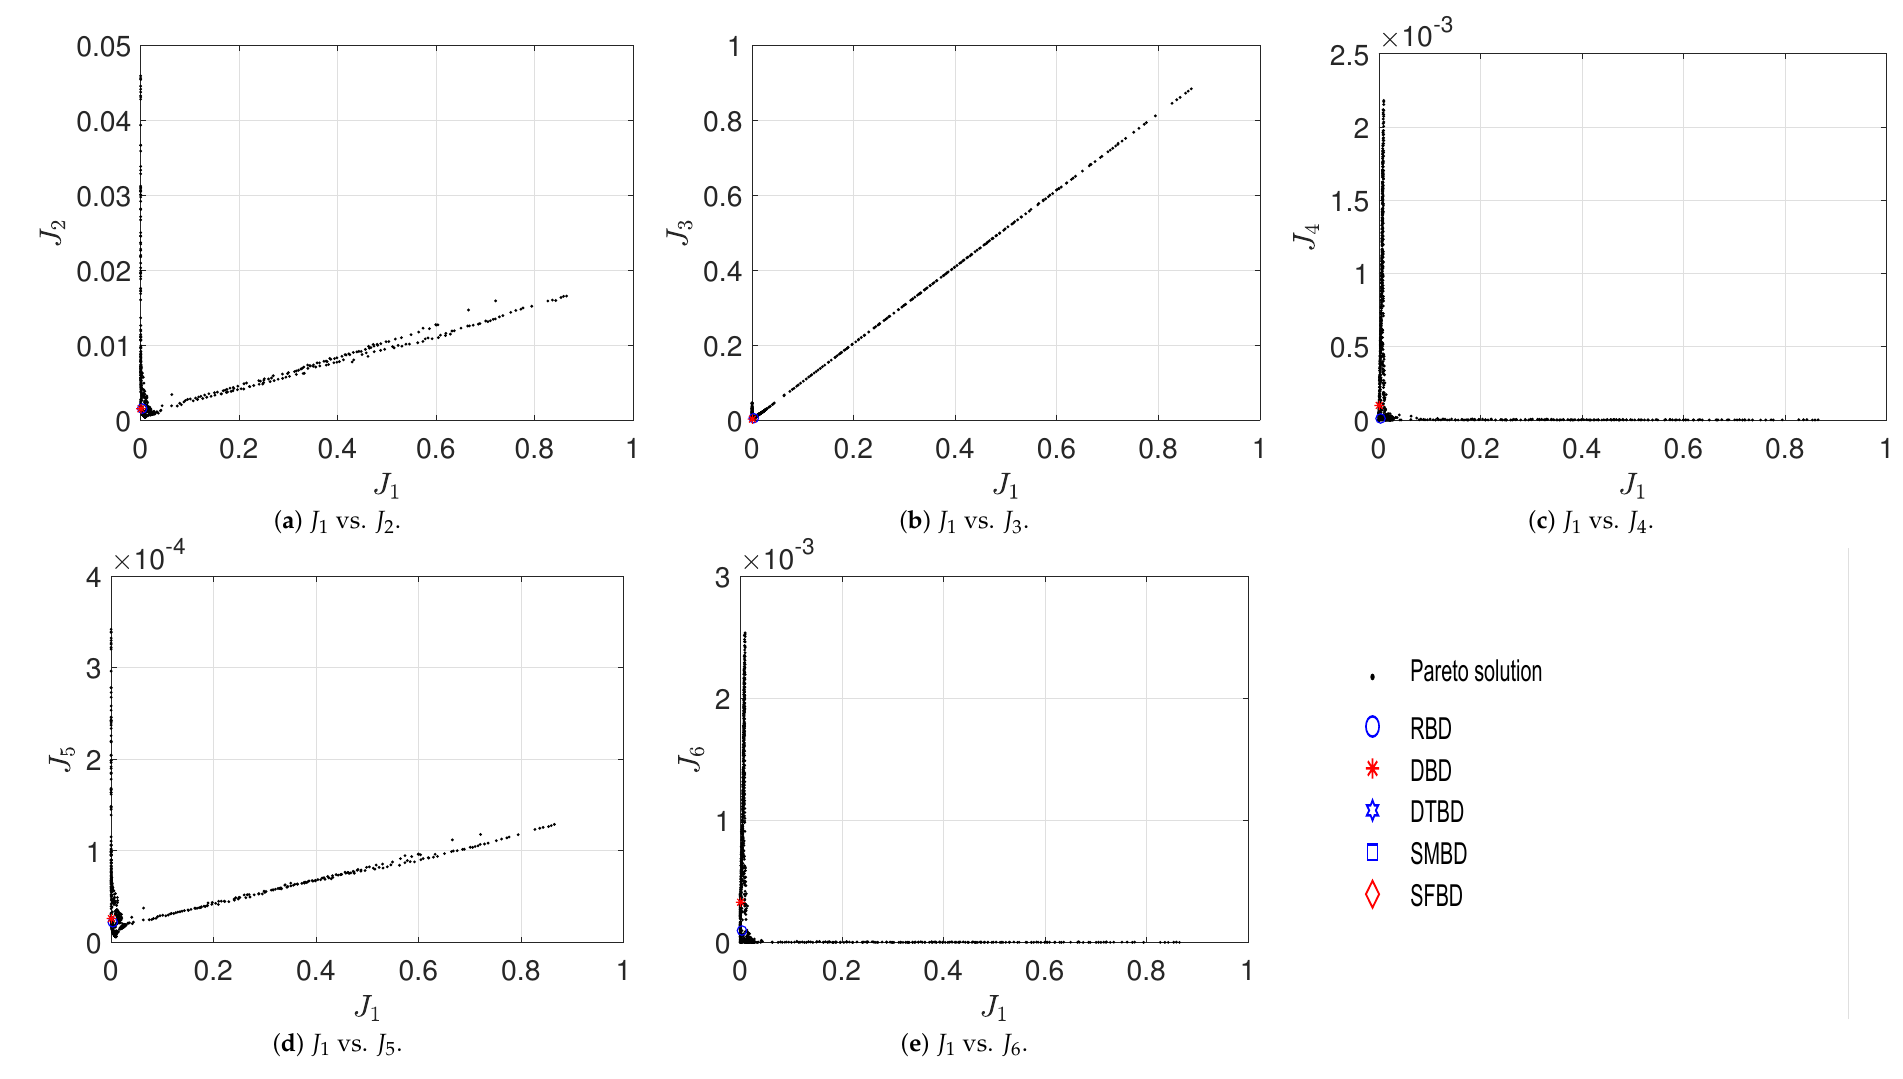
Figure 4. Pareto front in two-dimensional spaces